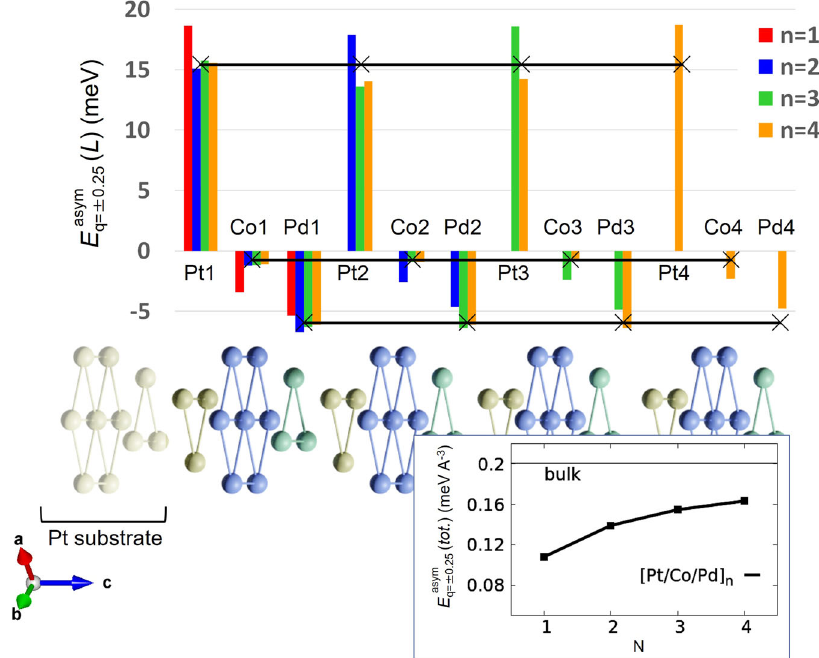
Fig. 4 Origin of the N-dependence of DMI in the [Pt/Co/Pd]-SL. The contribution of different atomic layer L to the asymmetric energy L ð Þ . The corresponding atomic layer contributions for bulk system, i.e. with between the spiral structures with wave vectors q = ±0.25, E asym q ¼ ±0 : 25 tot ð Þ is also shown. N = ∞ , are shown with black lines. The sequence of the layers is illustrated. The total asymmetric energy E asym q ¼ ±0 : 25